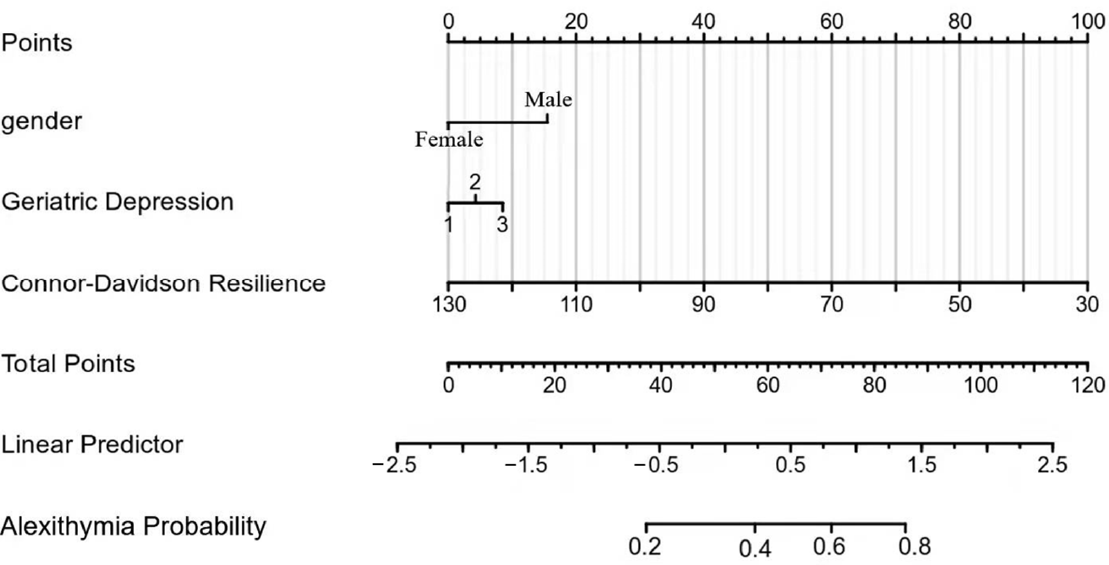
Figure 2. Nomogram of the alexithymia risk-prediction model.